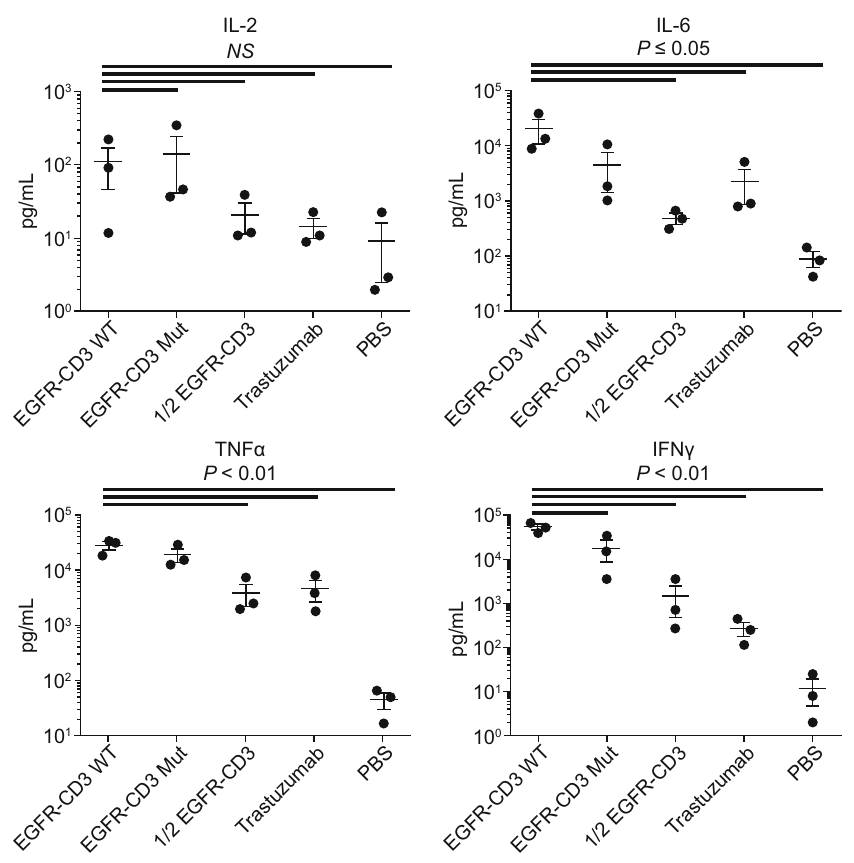
Figure 4. The role of DVD-Ig monovalent target binding on T cell function. Cytokines were measured by MSD in supernatants taken from huPBMC cultures incubated with the indicated antibody or DVD-Ig molecules (coated on plate at 1 μ g/well) for 48 h. Different donors ( n = 3) were simultaneously assayed. Statistic P -value was calculated using one-way ANOVA. NS, not signi fi cant.